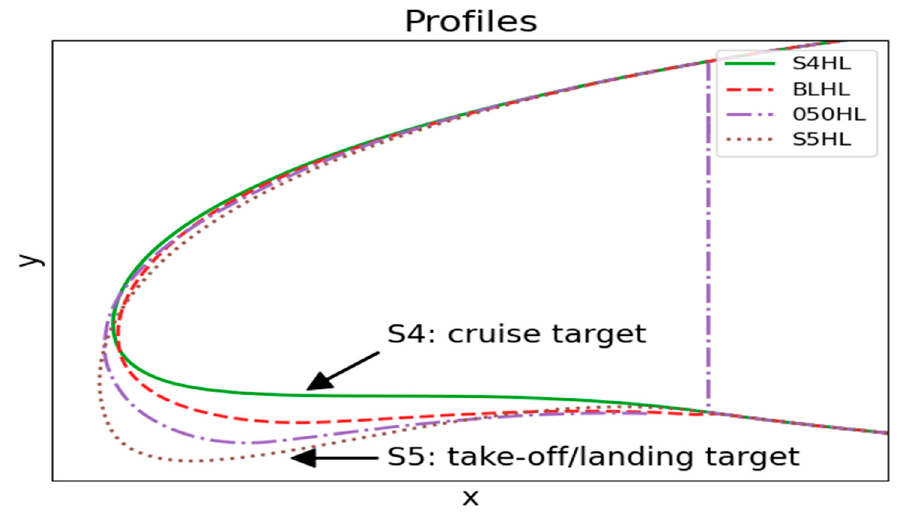
Figure 2. LE (leading edge) comparison of profiles S4HL, BLHL, 050HL, and S5HL [28].